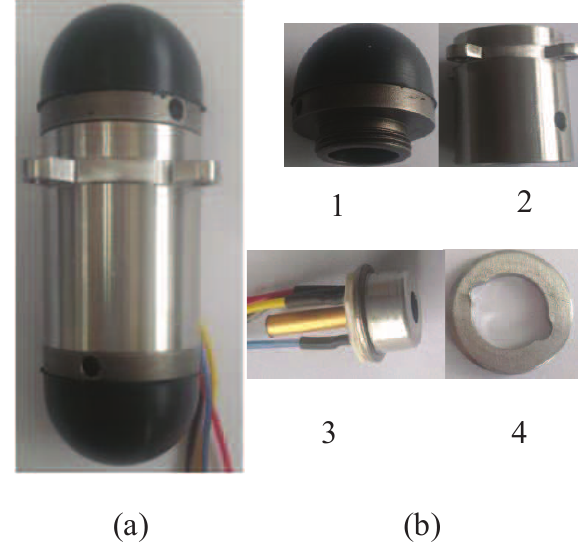
Figure 14. The photo of UTFS and part components. ( a ): UTFS; ( b ): part components (Note: 1. Flexible contact; 2. Sensor shell; 3. Sensor core; 4. Snap